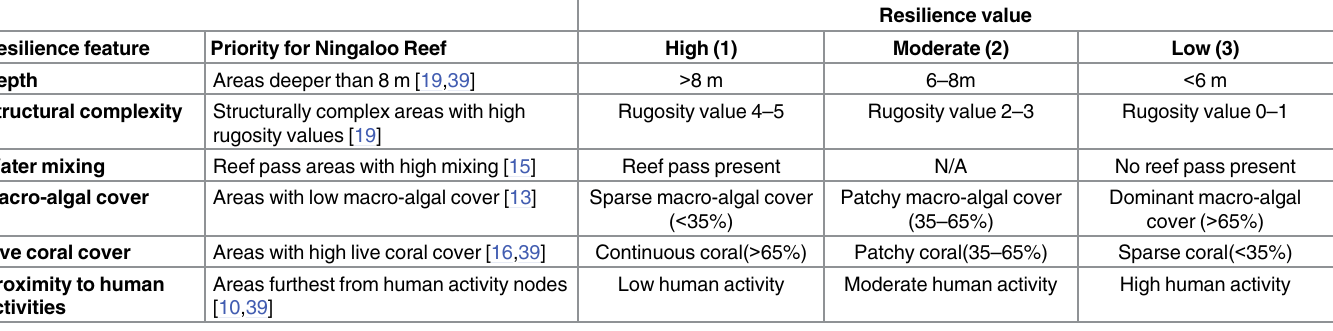
Table 3. Six climate change resilience features highly relevant for Ningaloo Marine Park, and the definition of resilience values assigned to each feature (Percentage values for macro-algal and live coral cover obtained from Kobryn et al.